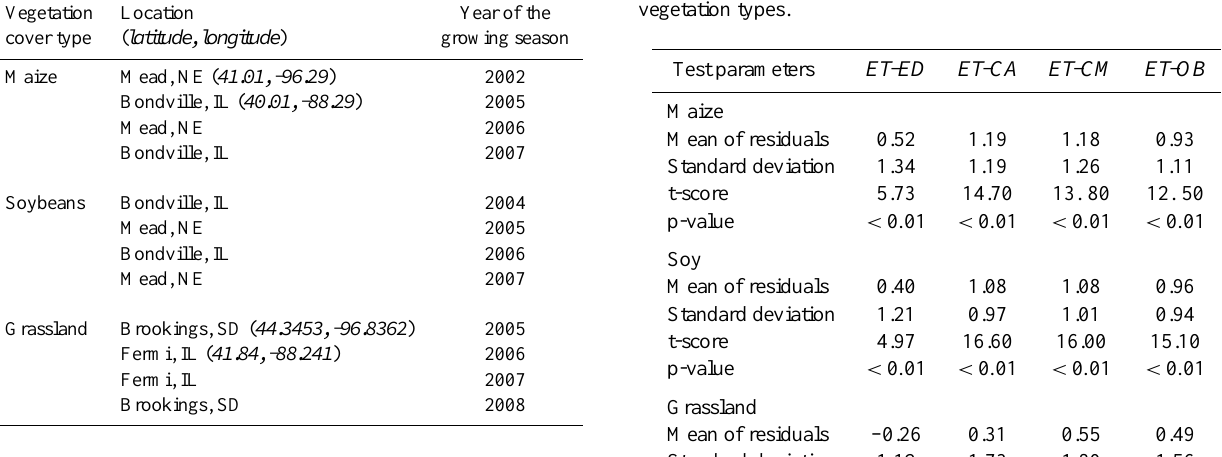
Table 2a. Presence of bias in VegET outcomes from different phe- nological parameterization sources: distributions are presented by vegetation